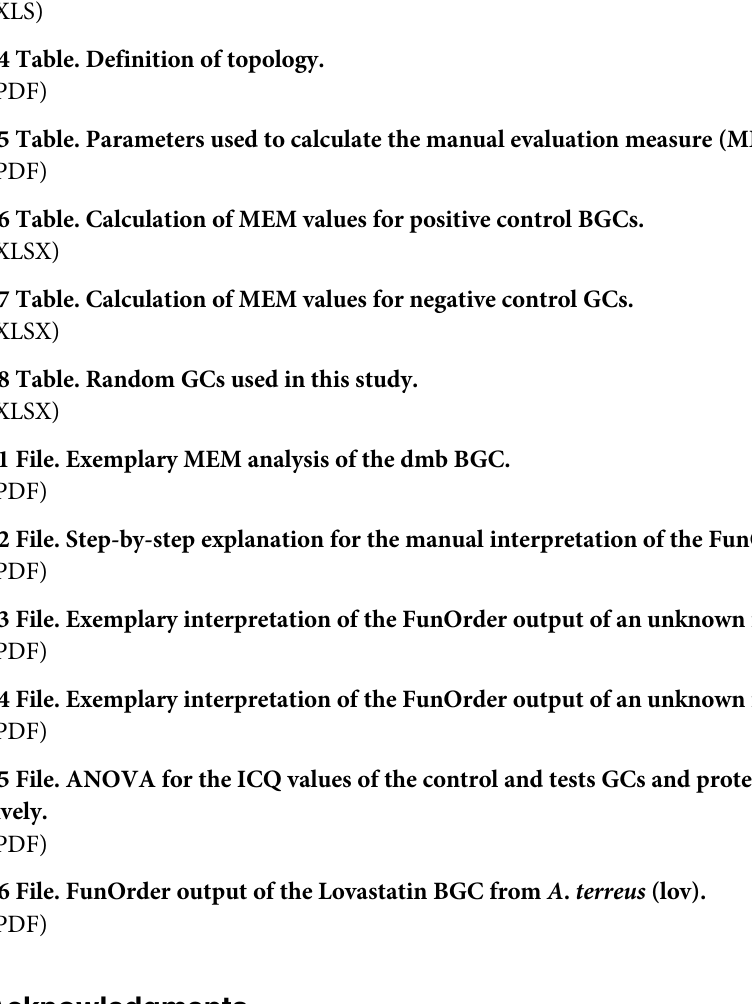
S1 Table. Empirically tested BGCs used as control set in this study. S2 Table. Protein sets of conserved metabolic pathways of the primary metabolism. S3 Table. Sequential GCs used in this study.